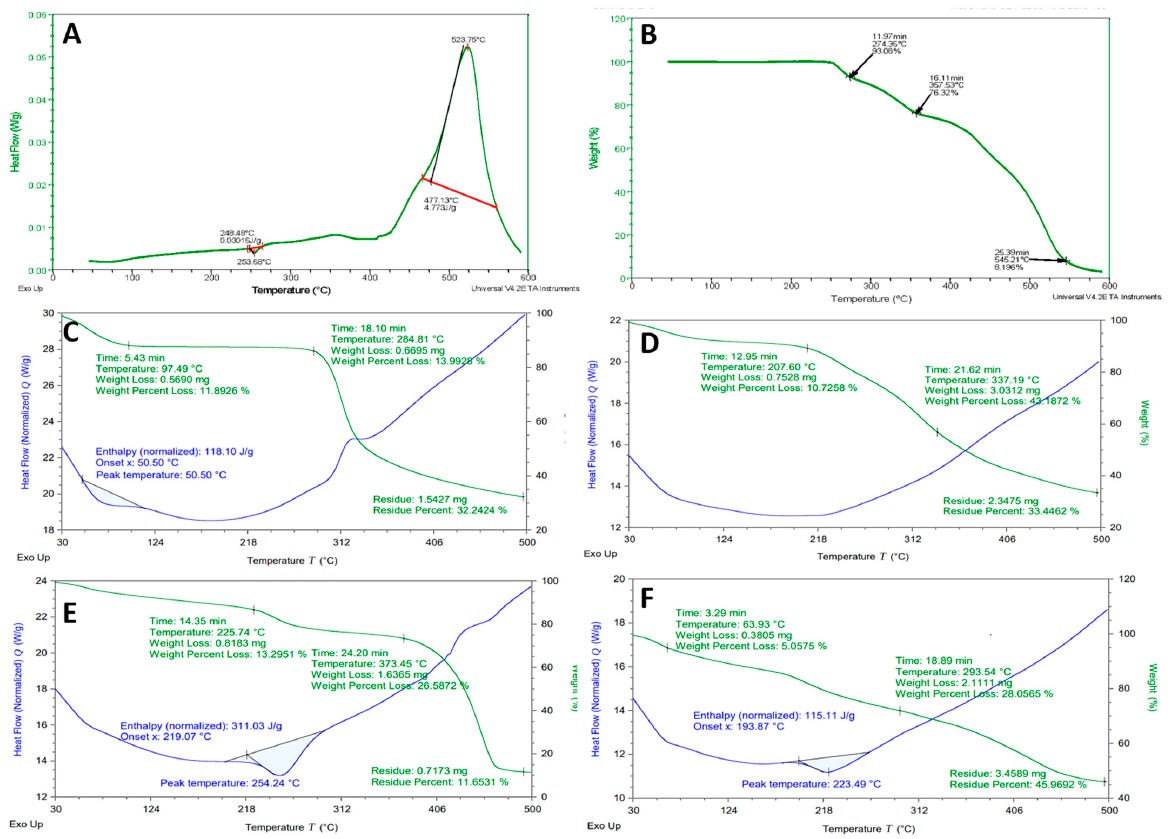
Figure 4. DSC and TGA thermograms: ( A ) DSC of Tofacitinib, ( B ) TGA of Tofacitinib, ( C ) chitosan, ( D ) mucin, ( E ) unloaded microparticles, ( F ) drug-loaded MU-CHI-Co-Poly (MAA) hydrogel microparticles. The blue color shows DSC and the green color shows TGA in ( C – F ). DSC and TGA thermograms of pure chitosan are shown in Figure 4C. DSC